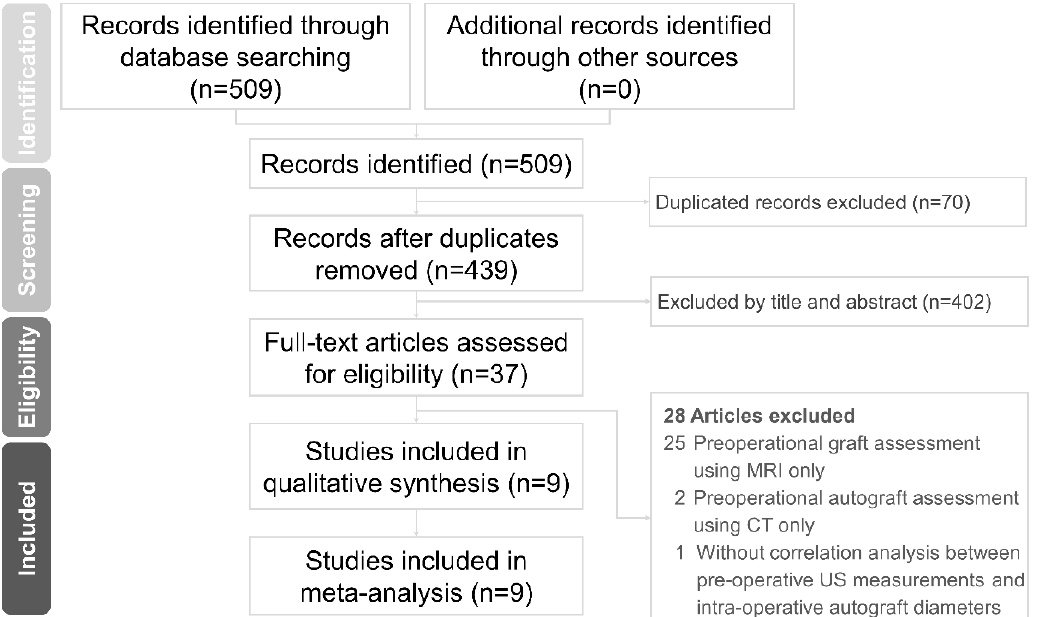
Figure 1. Flow diagram of the literature search based on the Preferred Reporting Items for Systematic Reviews and Meta Analyses (PRISMA) guidelines. MRI, magnetic resonance imaging; CT, computed tomography; US, ultrasound.